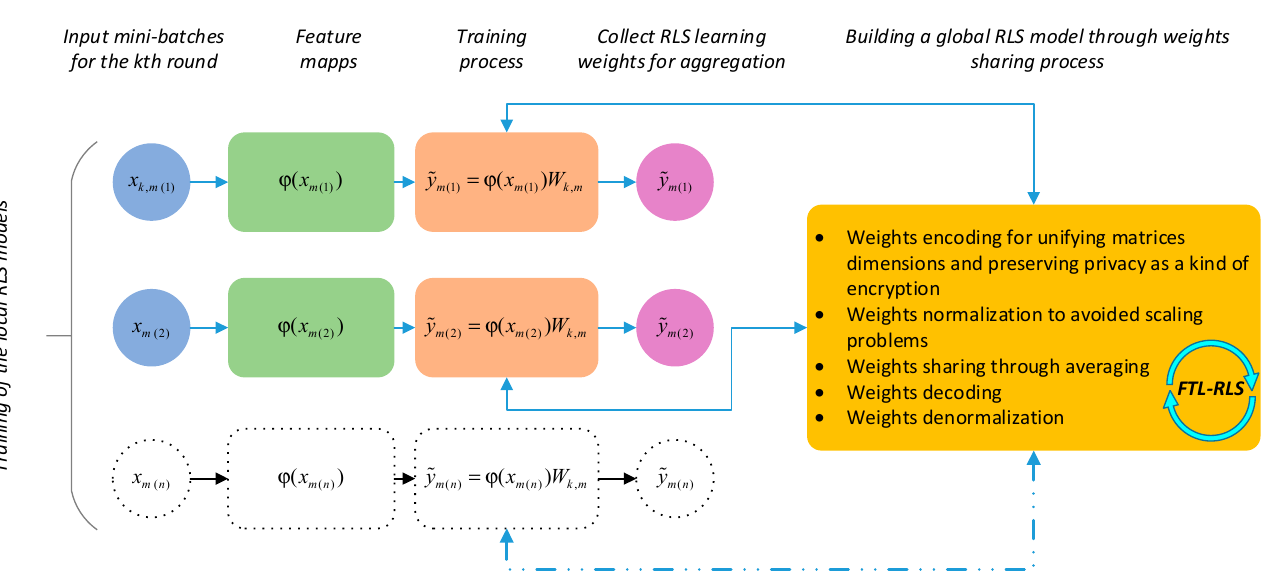
Figure 2. Flow diagram of the proposed FTL-RLS.